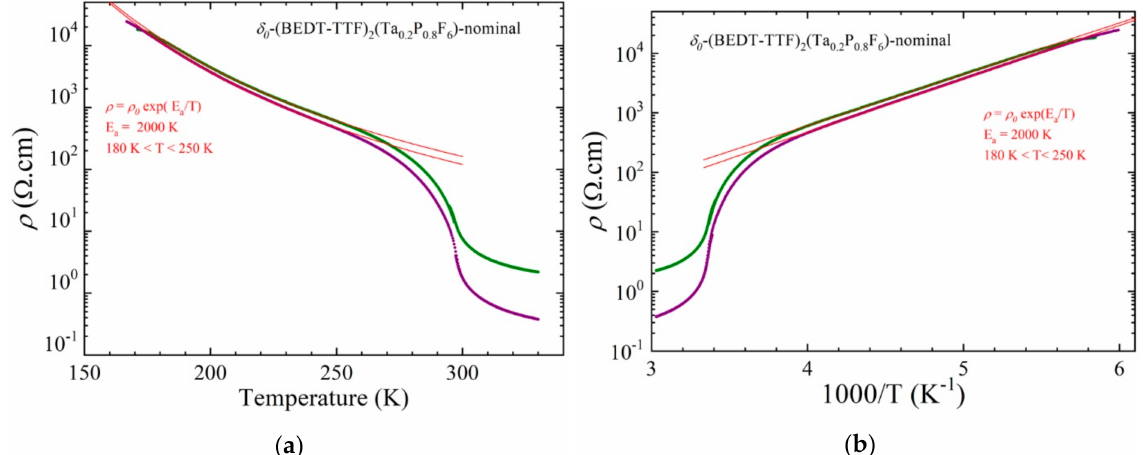
Figure 13. Temperature dependence of the electrical resistivity of two single crystals of a δ o -(BEDT-TTF) 2 (Ta 0.2 P 0.8 F 6 )- nominal plotted as log ρ versus T ( a ) and log ρ versus 1/T ( b ). The red lines are linear fit to the data giving the activation energy E a below 250